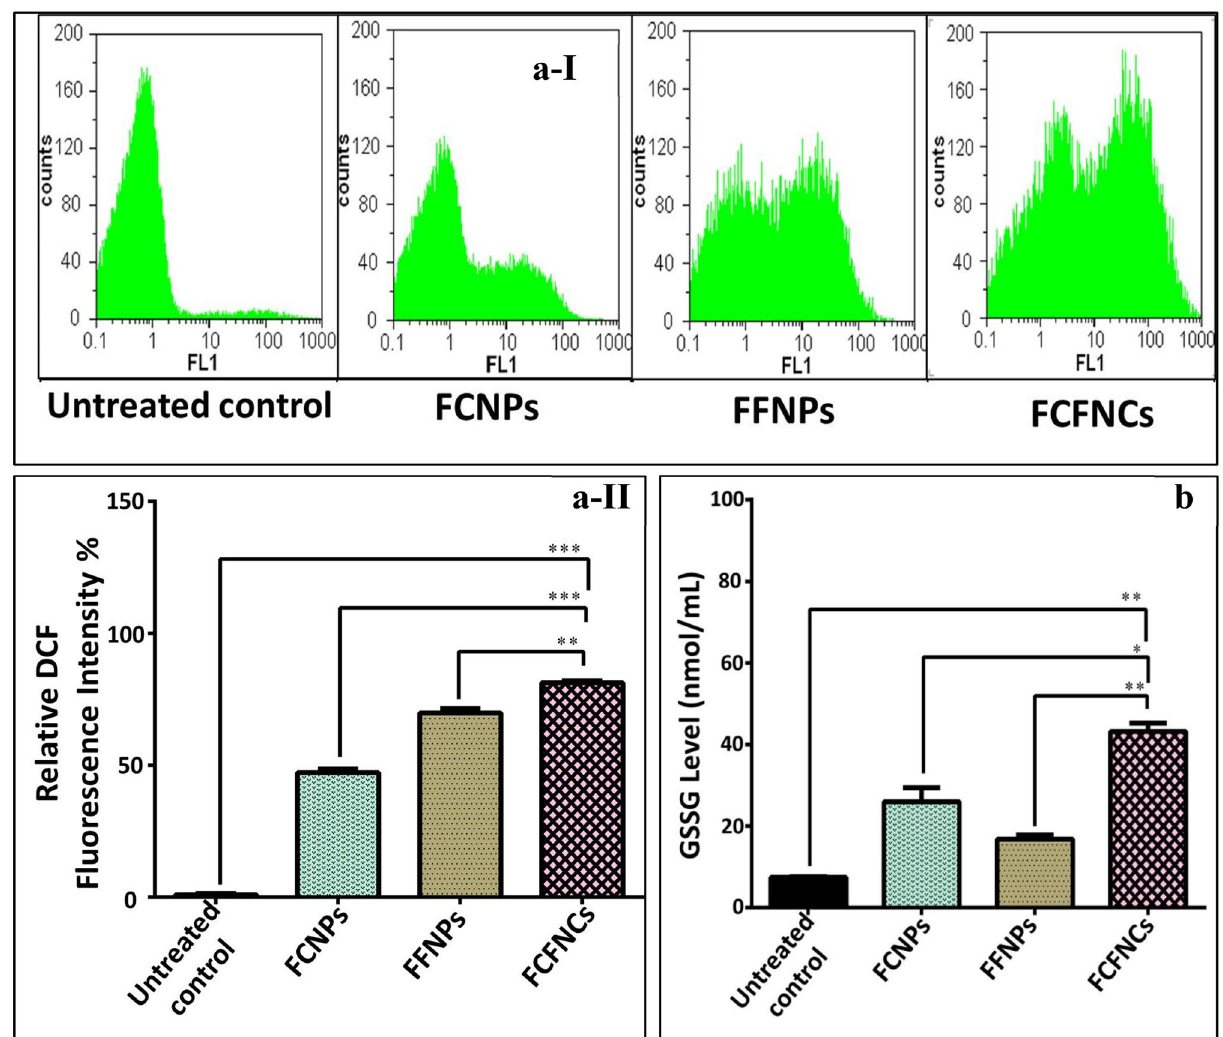
Figure 5. Prooxidant effect of FCNPs, FFNPs and FCFNCs in the treated HepG-2 cells relative to the untreated cancer cell lines. ( aI , II ) Flow cytometric charts of fluorescence oxidized form of dichlorofluorescin diacetate (indicator of reactive oxygen species “ROS”) with quantitative histogram for the percentage of intracellular ROS. ( b ) Cellular content of GSSG (nmol/mL) in FCNPs, FFNPs and FFNPs -treated HepG-2 relative to the untreated cells. All values were expressed as mean ± SEM. FCFNCs were compared with all other treatments with significance at *p < 0.05, **p < 0.005, ***p <